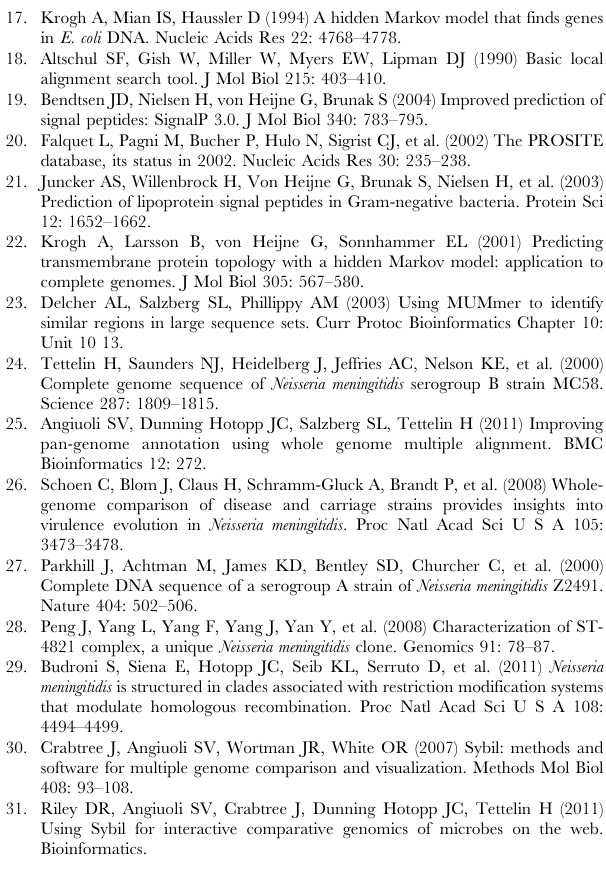
the reference. The horizontal axis shows nucleotide positions in the sequence. The vertical axis shows percentage of matching nucleotides at each position. Percent identity ranges from 50 (bottom) to 100 (top) percent in each row. (TIF) Figure S2 Alignment of predicted amino acid sequence of early strain type (upper sequence) and late strain type (lower sequence) PorB (NMY220_1828 and NMY233_1807) showing non-conserved amino acids. Boxes outline loops V (*) and VII ( + ), which were previously reported. (TIF) Figure S3 Alignment of predicted protein lactoferrin binding protein B (LbpB) showing non-conserved amino acids. Upper sequence early clone (NM220), lower sequence late strain type (NM233). (TIF) Figure S4 Alignment of predicted protein hemoglobin- haptoglobin utilization protein A (hpuA) showing non- conserved amino acids. Upper sequence early strain type (NM220), lower sequence late strain type (NM233). (TIF) Figure S5 Alignment of predicted protein PilC1, show- ing non-conserved amino acids. Upper sequence early strain type (NM220), lower sequence late strain type (NM233). (TIF) Table S1 Available sequenced genomes. (DOCX)